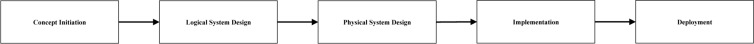
Software development process of ProtoDLS.